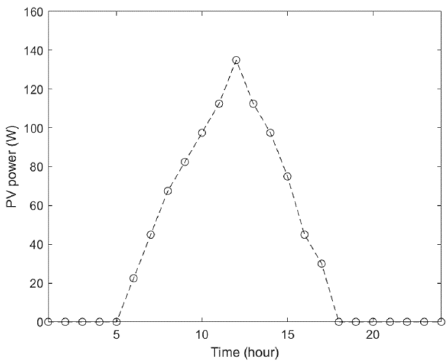
Figure 4. Daily output power of a PV panel.